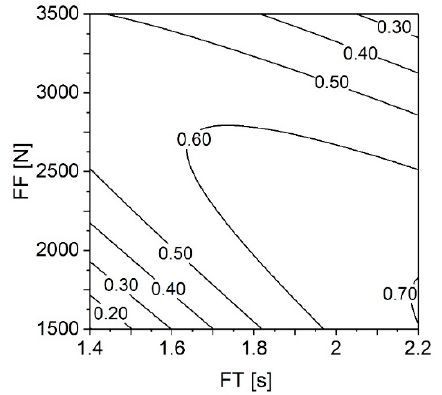
Figure 18. Contour plot for VR(U) correlated with FT and FF ranges. RS set at 21,000 rpm, FoT at 1.5 s, and FoF at 4500 N.